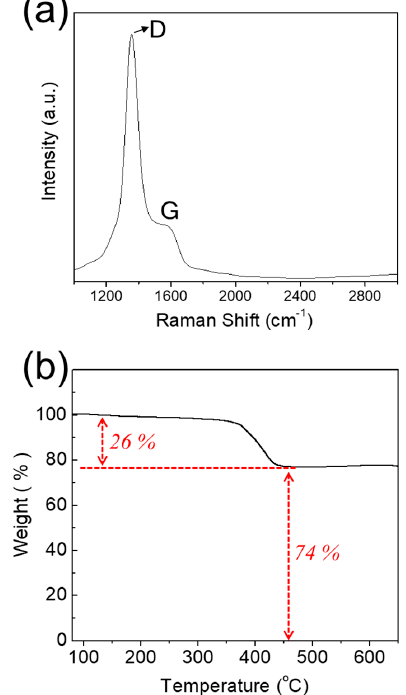
Figure 3. ( a ) The Raman spectrum and ( b ) thermogravimetric analysis (TGA) curve of the MoO 3 /C composite